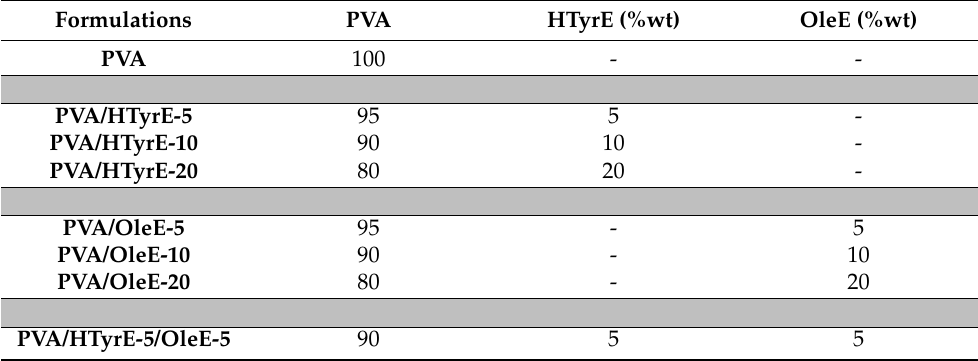
Table 3. Material formulations of PVA and PVA based films.